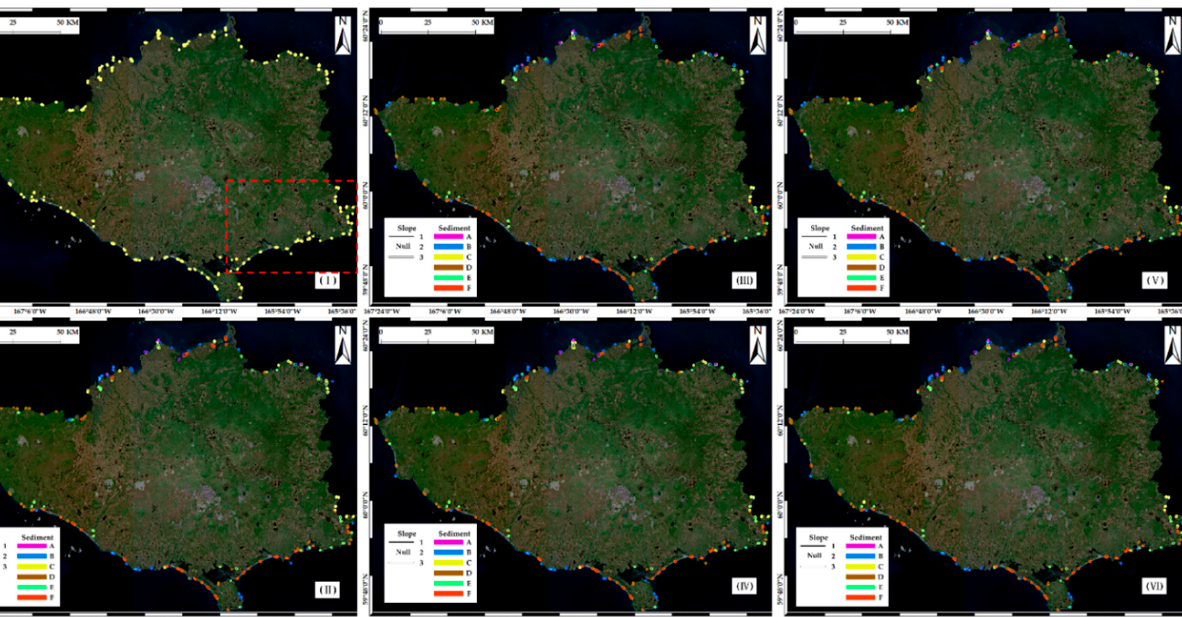
Figure 6. Detailed results of the coastal zone classification by comparison with the validation data. ( I – IV ) Coastline classification error results derived from the optimal features, all features, Sentinel- 2 features, and ICESat-2 features, respectively. We only show the misclassification results in Figure 6, which are indicated in red colors.